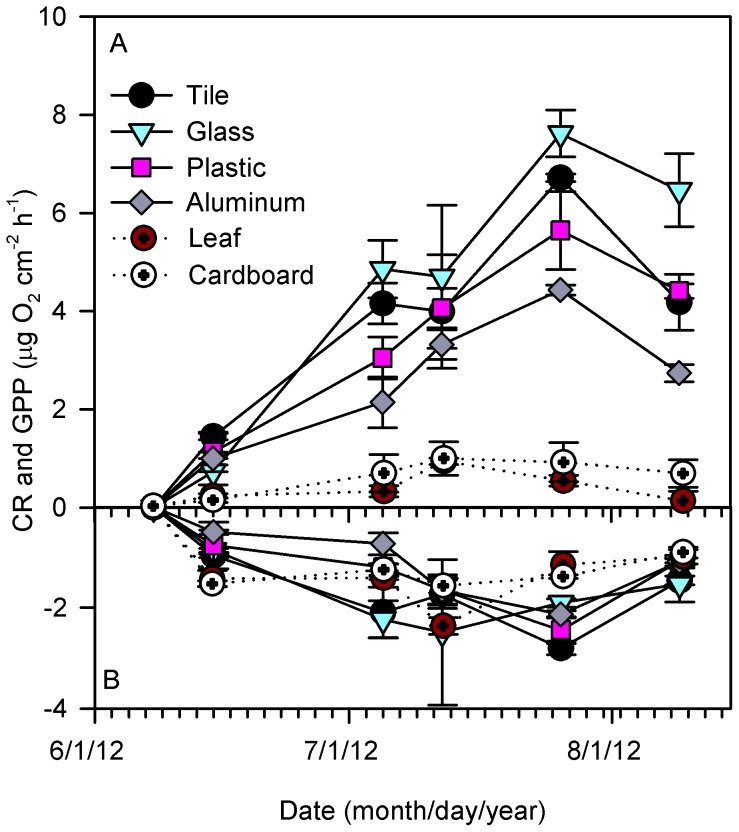
Mean (±SE) gross primary production and community respiration for biofilms colonizing natural substrates (unglazed ceramic tile and leaves) and anthropogenic litter substrates including glass, hard plastic, aluminum, and cardboard, incubated in artificial streams during summer 2012 (N = 18 date−1).